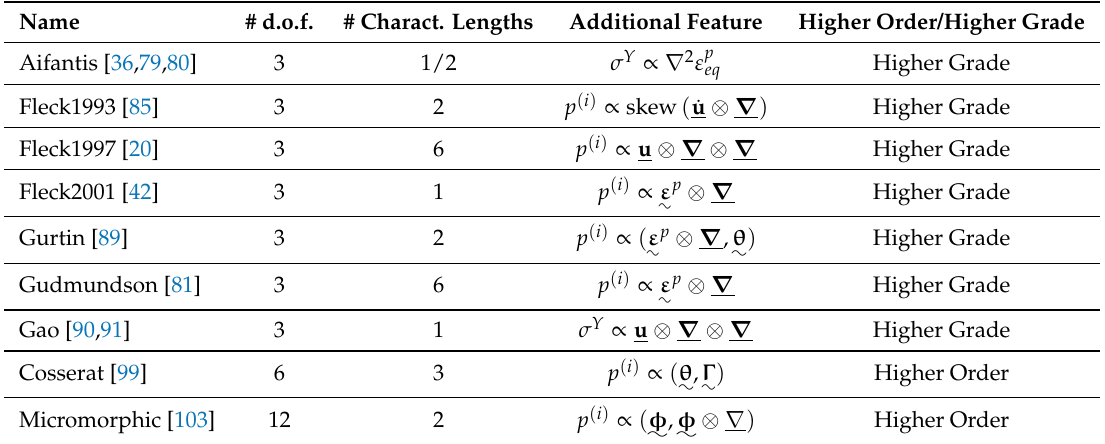
Table 1. Summary of the presented